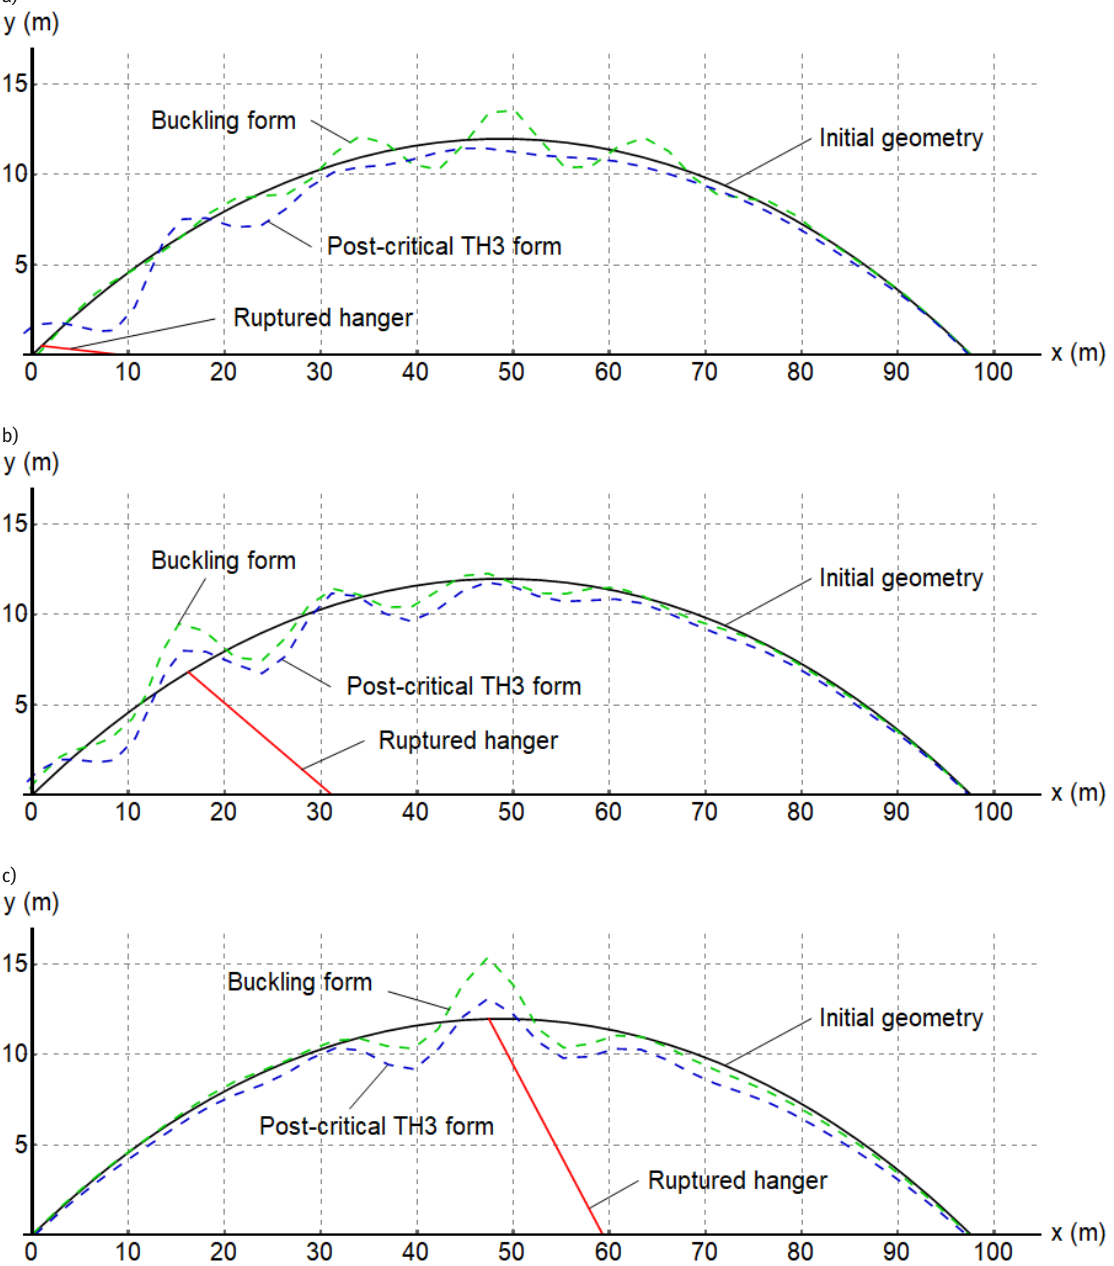
Figure 24: Scaled, exampled deformations of instability forms of the arch between skewbacks from LBA and TH3 analysis: rupturing the leftmost hanger (a), rupturing the hanger in one-fourth of the span (b), and rupturing the hanger in the midspan